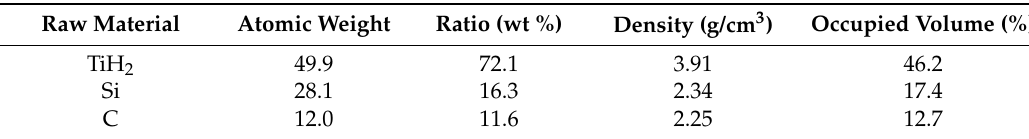
Table 1. The volume ratios of the raw materials.